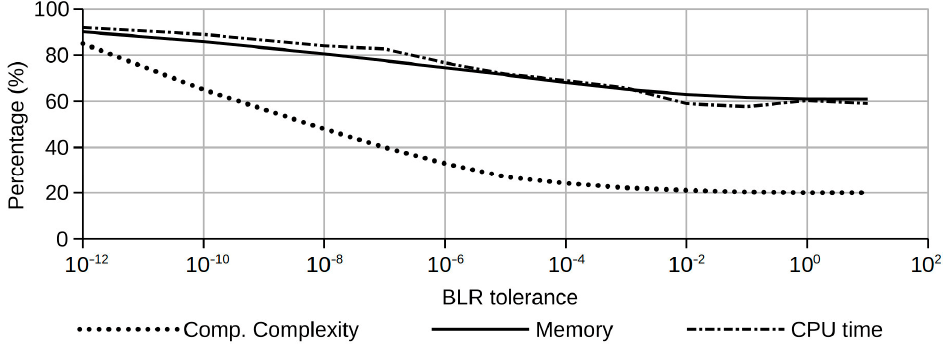
Figure 8. Dependence of computational complexity of the LU-factorization procedure, the amount of memory, and CPU time required to solve the whole numerical problem when applying low-rank approximation as a percentage of the corresponding value for full-rank factorization.